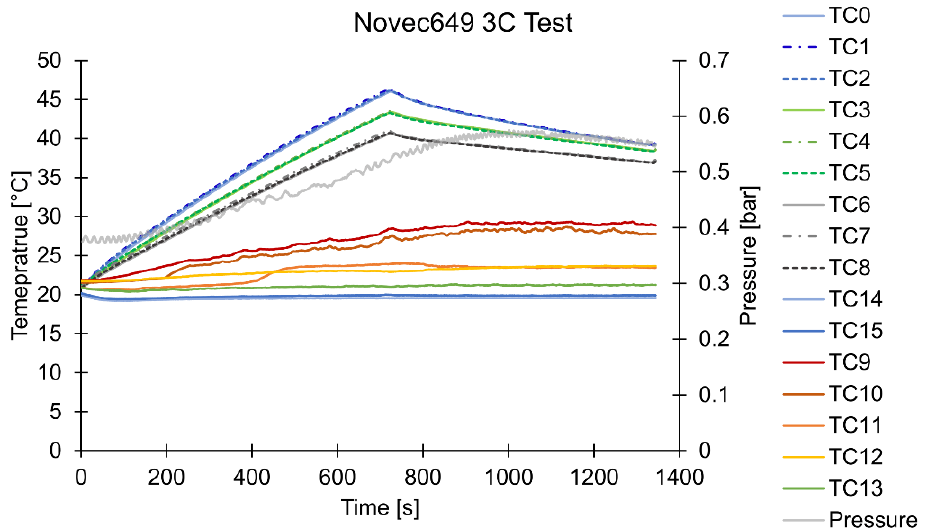
Figure 13. Fast Charging test results with 3C.